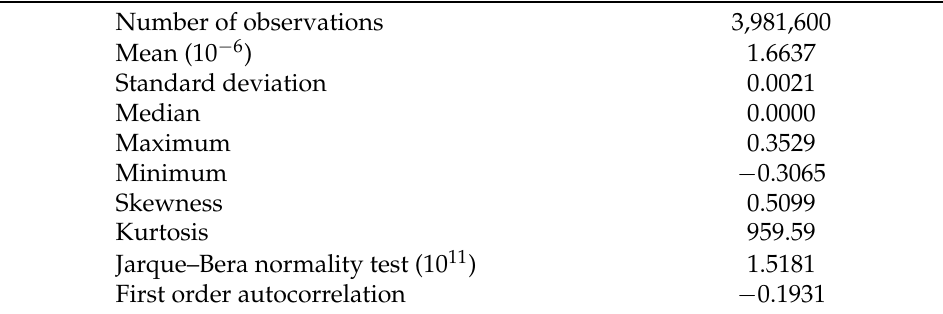
Table 1. Descriptive statistics of 1 min bitcoin